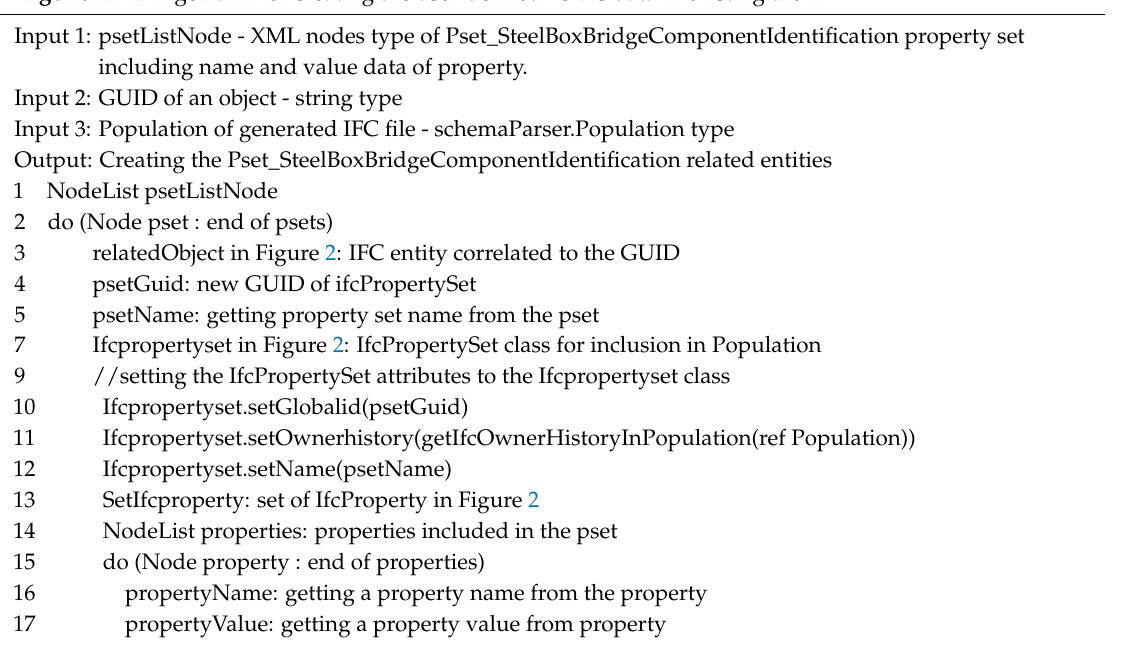
Figure 8. Developed user-interface for generating and managing the semantic information of a bridge component. Algorithm 1. Algorithm for creating the user-defined PSETs data in existing the